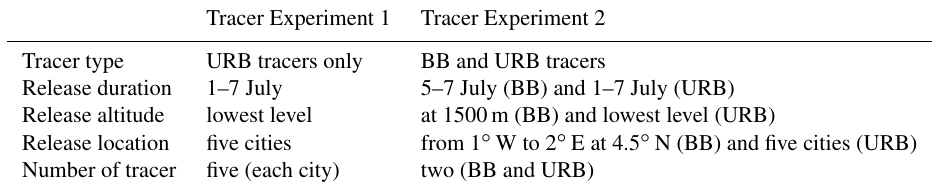
Table 3. Main characteristics of the two numerical tracer experiments using high-resolution modeling at 2km grid spacing with tracer emissions relevant for biomass burning (BB) and urban pollutants